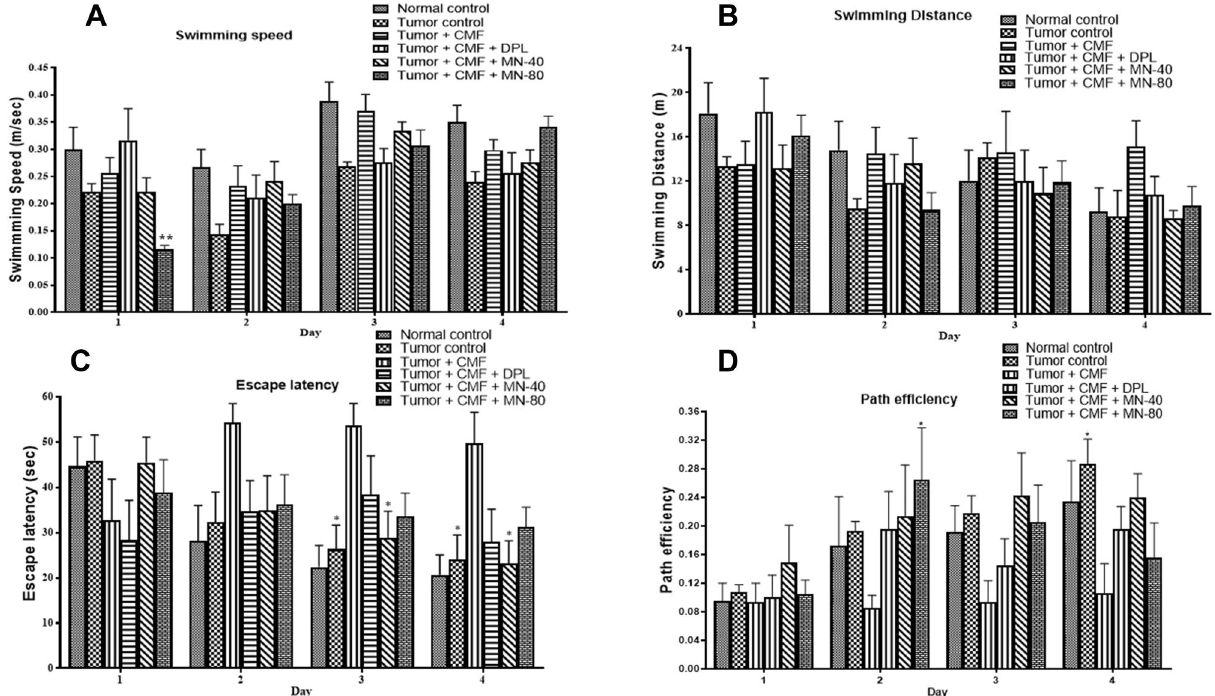
Figure 3. Effect of Mulmina (MN), Cyclophosphamide + Methotrexate + 5-Fluorouracil (CMF), Donepezil (DPL) on ( A ) Swimming speed ( B ) Swimming distance ( C ) Escape latency ( D ) Path efficiency on tumor- bearing animals in MWM acquisition trial. Values are expressed as mean ± SEM (n = 3–4). Statistical analysis was done by using two-way ANOVA followed by Bonferroni’s post-hoc test .*p < 0.05,**p < 0.01 compared to tumor + CMF treated